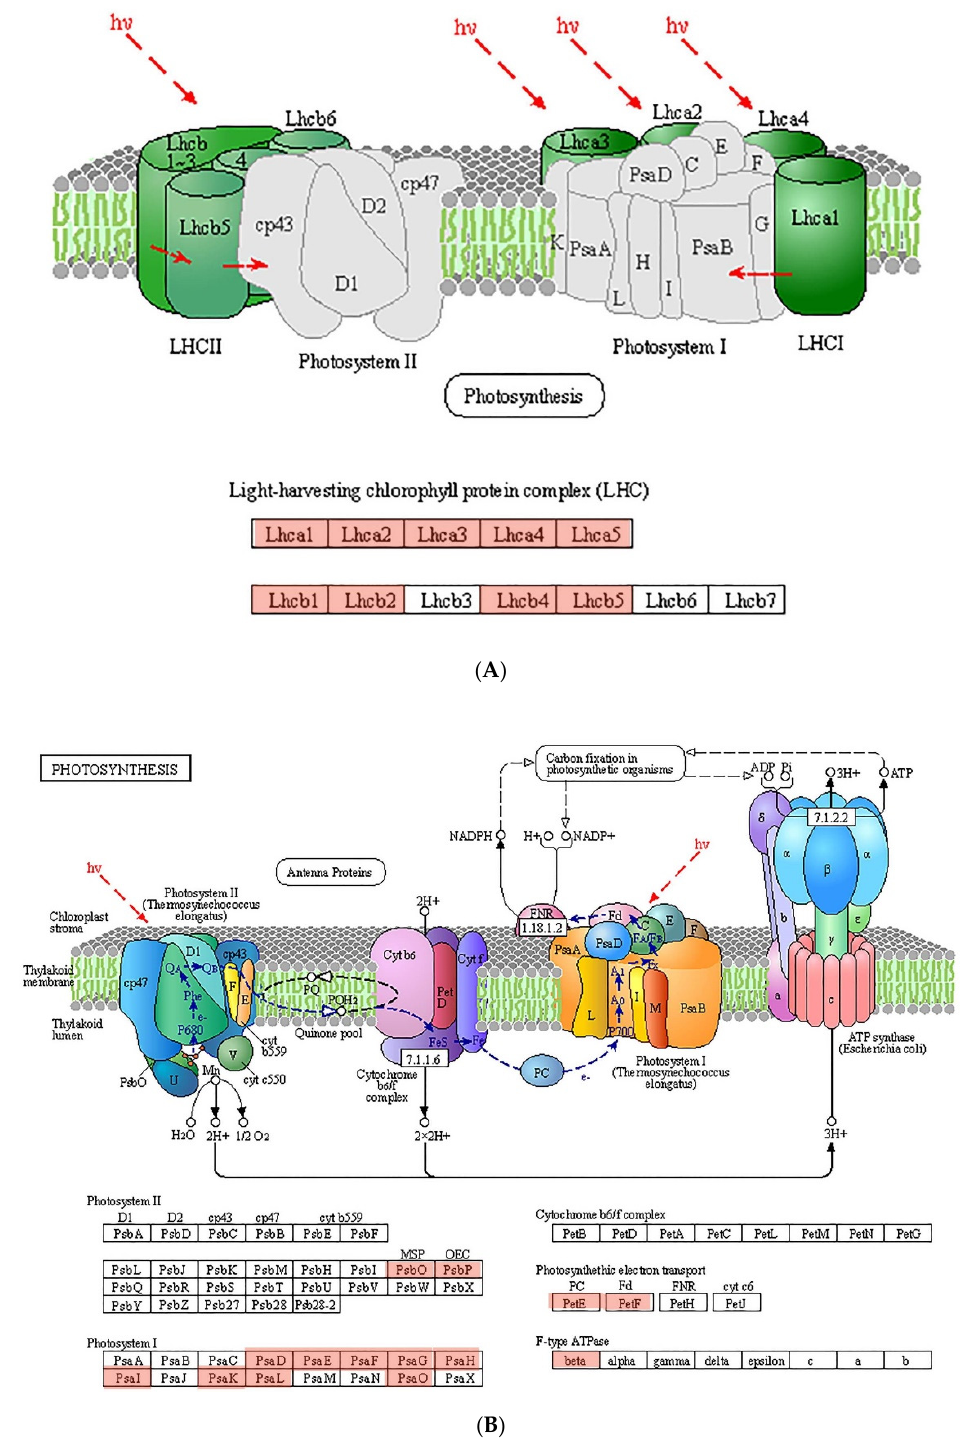
Figure 6. Schematic of the light-harvesting chlorophyll protein complex ( A ) and photosystem ( B ). Proteins and subunits are distinguished by different colors. The up-regulated proteins are marked in light red at the bottom of figure.